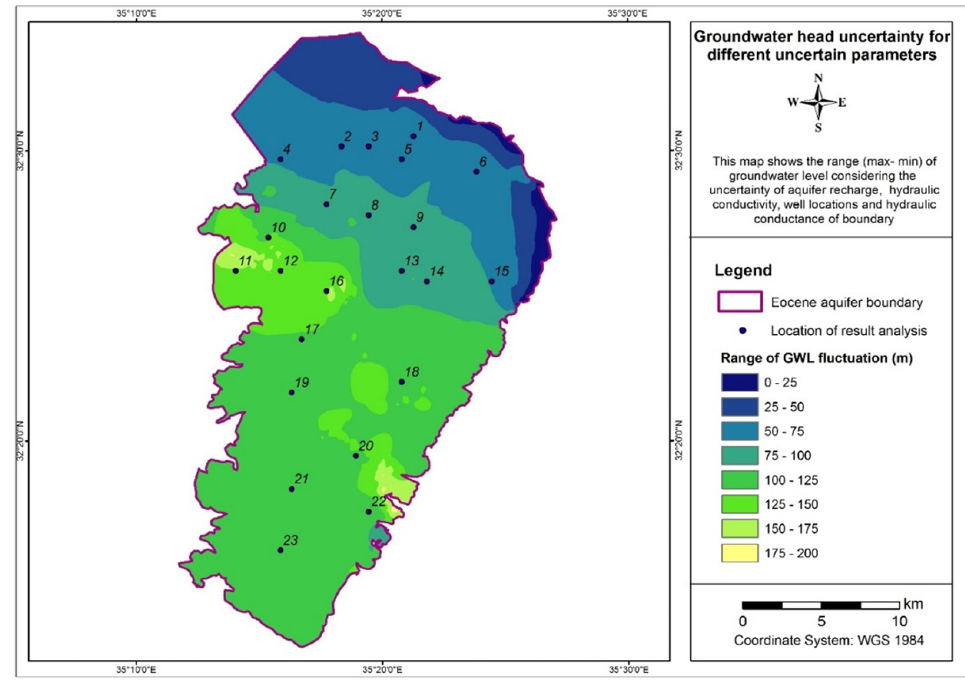
Figure 18. Groundwater fluctuations due to combined parameter uncertainty.